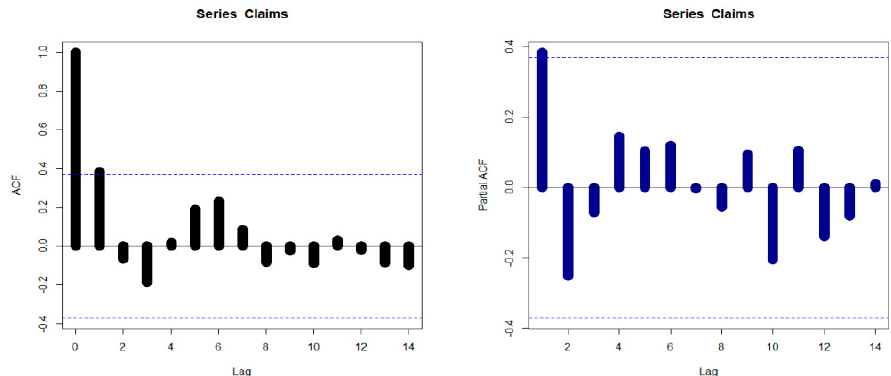
Figure 12. The scattergrams.